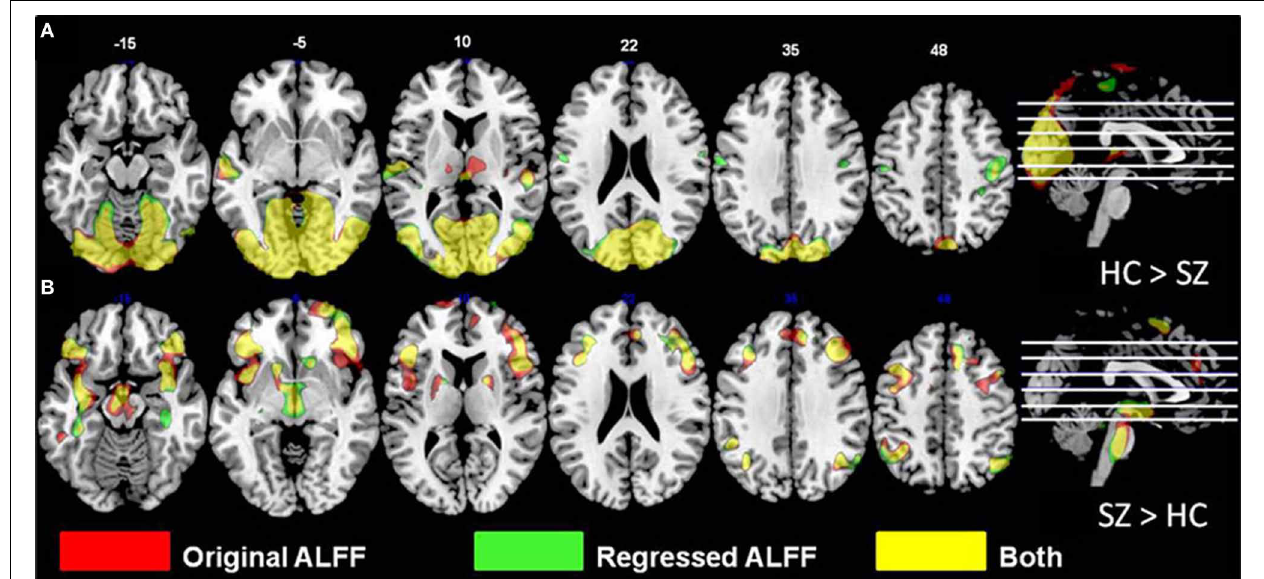
FIGURE 3 | The differences in ALFF values between diagnostic groups. (A) Areas where healthy subjects had significantly larger values than subjects with schizophrenia, thresholded at p < 0 . 05 (FDR corrected; t > 2 . 6), for original and regressed ALFF (red and green, respectively). All suprathreshold voxels for a given contrast are shown